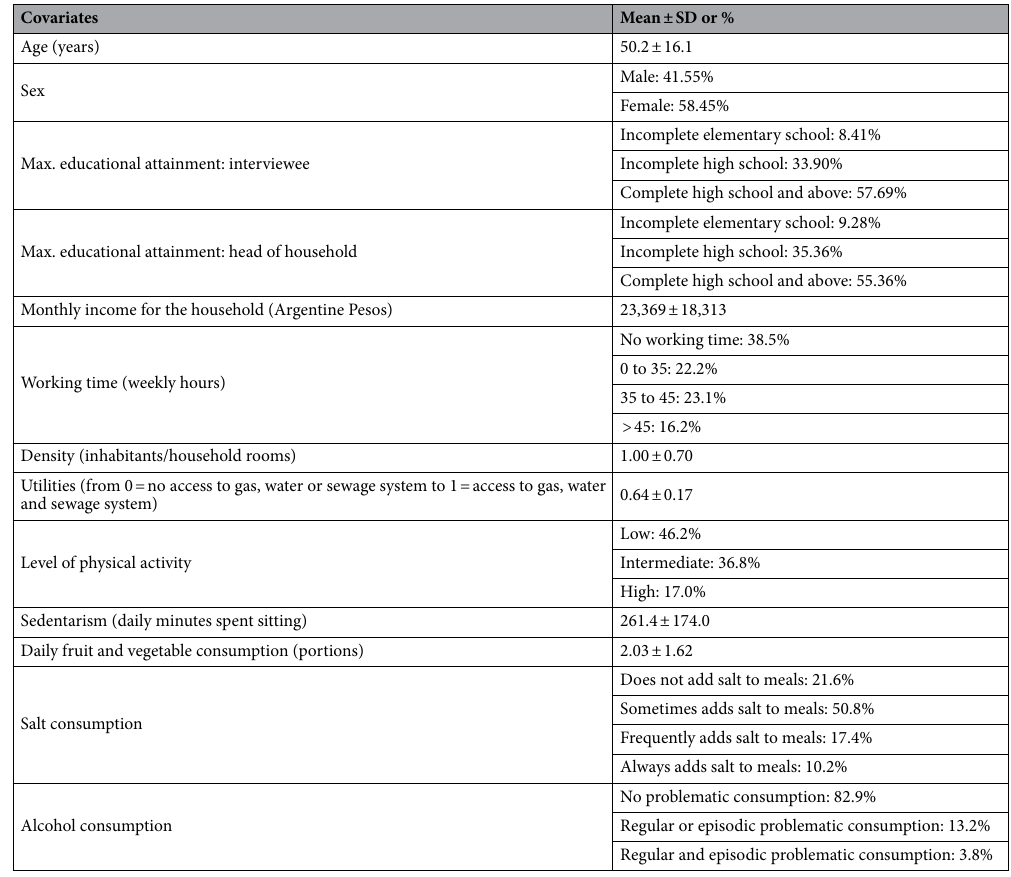
Table 1. Summary for all covariates used as explanatory variables in the